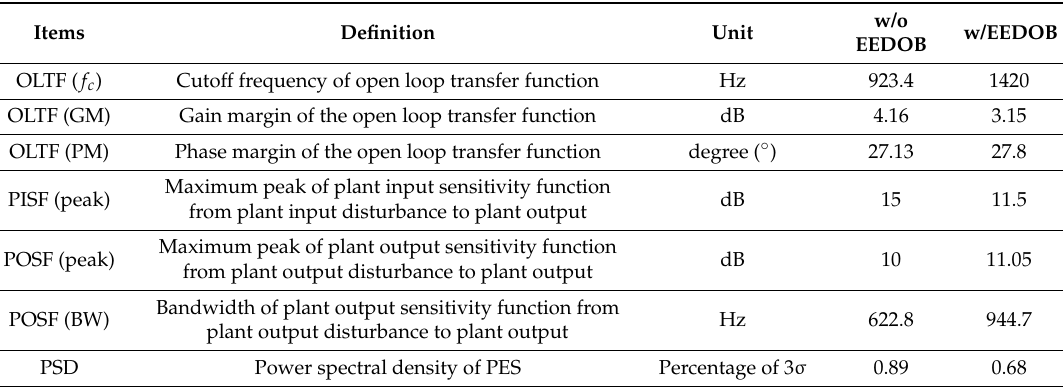
Table 1. Performance of vibration reduction.